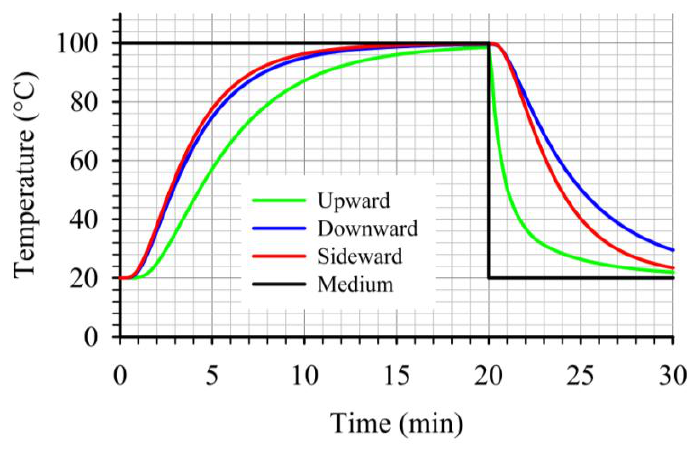
Figure 12. Comparison of temperature profiles at the critical point during thermal processing of peach halves of different orientations in syrup (20% sugar) in stationary metal